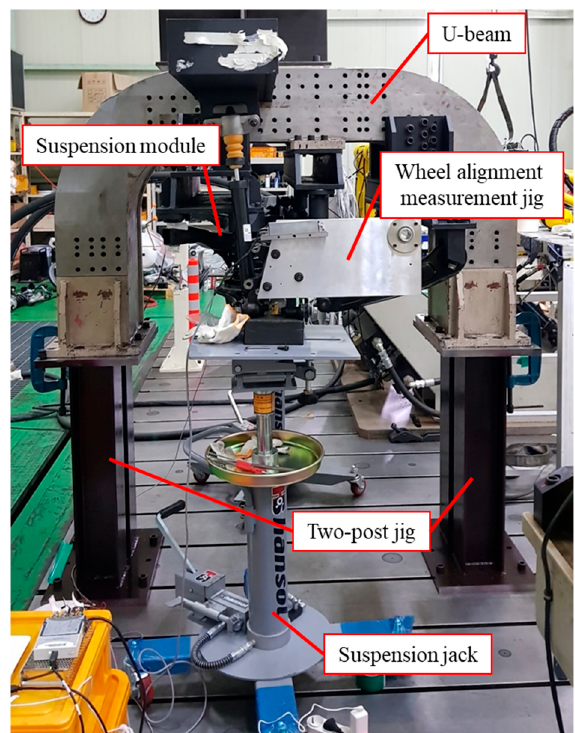
Figure 11. Experimental setup for wheel alignment inspection.